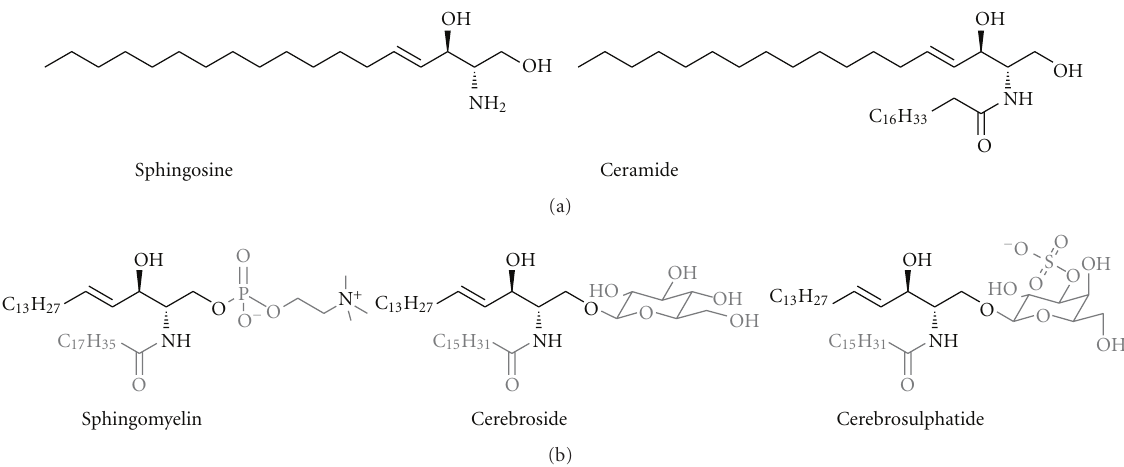
Figure 1: (a) The chemical structures of sphingosine and C 18 -ceramide; (b) the lipids isolated by Thudichum.